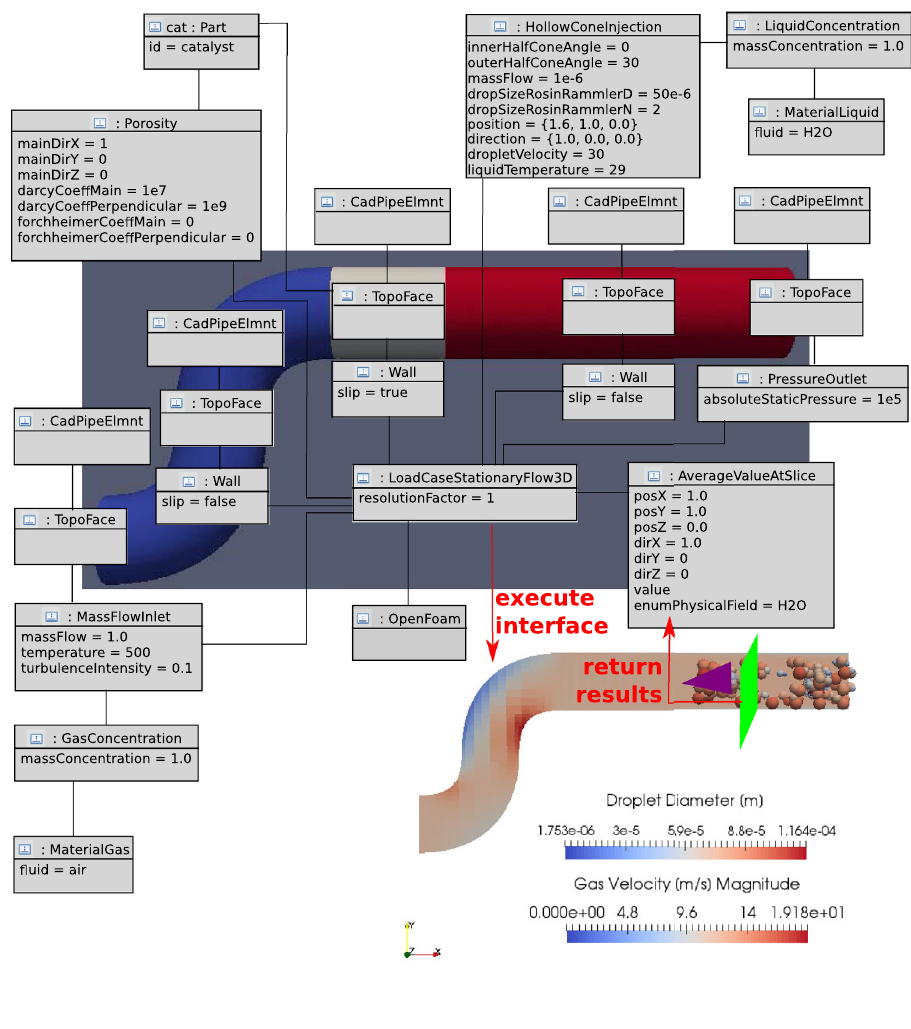
Fig. 13 Design graph in instance diagram form of the ‘classic’ design language of the SCR exhaust aftertreatment system. The CFD boundary conditions are added to the CAD topology of an exhaust system. The system contains the catalyst (white) and an upstream hollow cone injec- tor to inject the reduction agent. The system component instances are not shown for space reasons. Reproduced from and more details in